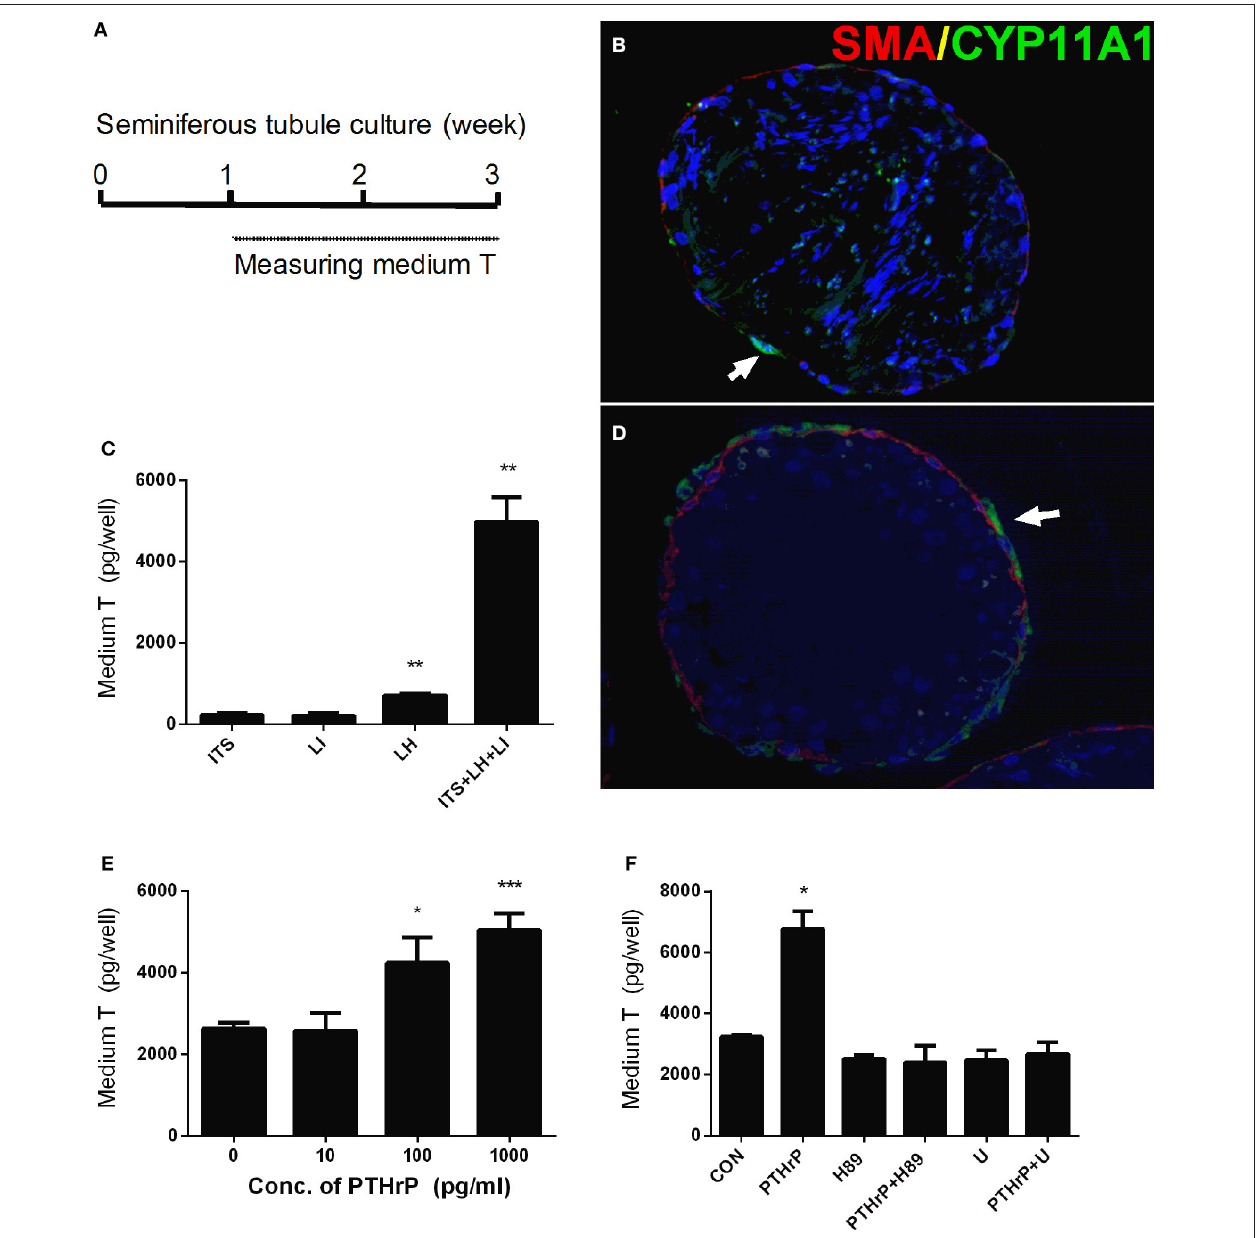
FIGURE 1 | PTHrP induces stem Leydig cell differentiation in vitro . Scheme of stem Leydig cell culture for 21 days (A) . Staining of Leydig cells using CYP11A1 in the cross sections of the seminiferous tubules after 14 days in the ITS medium (B) and LH + ITS + LI medium (D) . α -SMA (SMA, red color) was used to label peritubular myoid cells and CYP11A1 (green color, white arrow) was used to label Leydig cells. Medium testosterone levels after 14 days in ITS, LH, LI, and ITS + LH + LI (C) , ITS + LH + LI together with various concentrations of PTHrP (E) as well as 1,000 pg/ml PTHrP with or without H-89 (1 µ M) or U73122 (U, 1 µ M) (F) . Mean ± SEM, n = 6, * P < 0.05, ** P < 0.01, *** P < 0.001 when compared to the